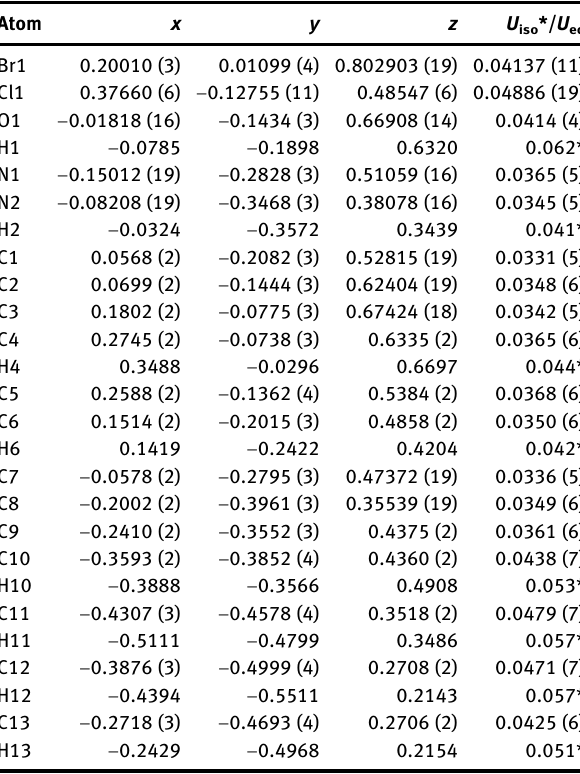
Table  : Fractional atomic coordinates and isotropic or equivalent isotropic displacement parameters (Å 